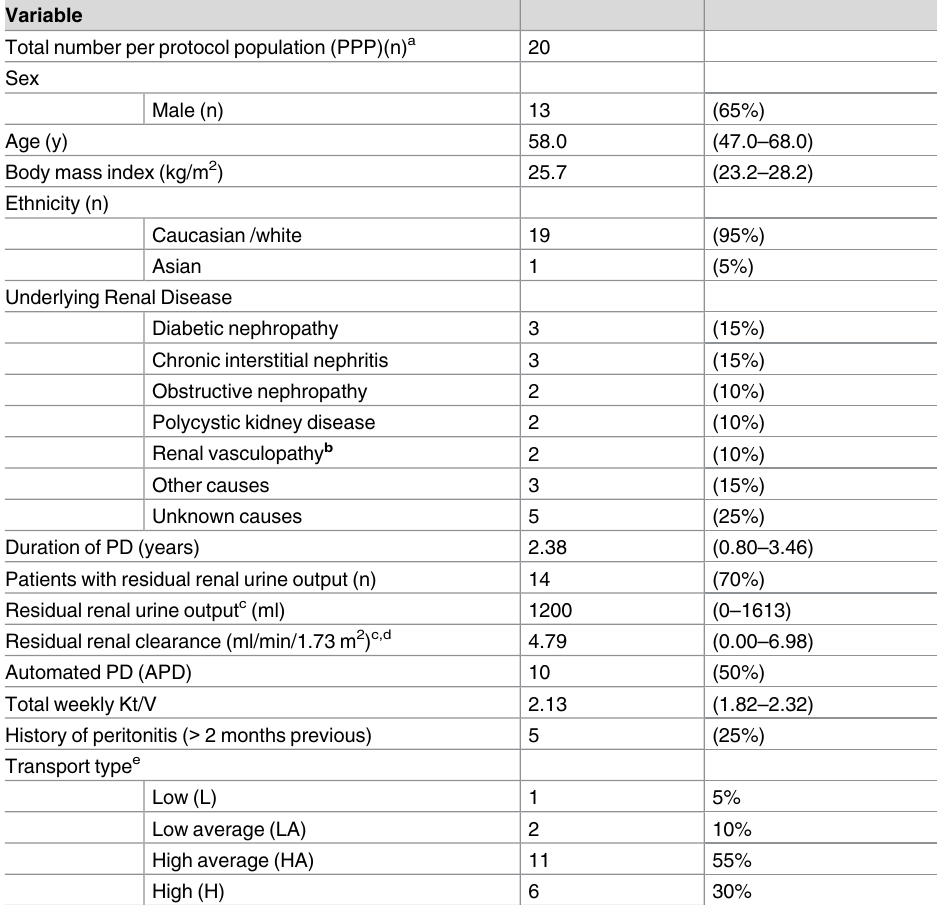
Table 1. Baseline characteristics of the study